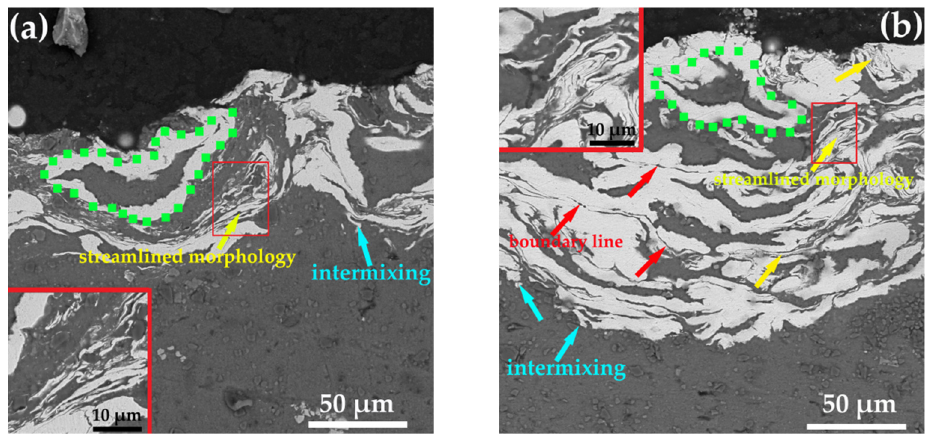
Figure 7. Cross-section morphologies of Ni-coated Al coatings deposited onto an Al substrate at an accelerating gas temperature of ( a ) 200 °C and ( b ) 400 °C.